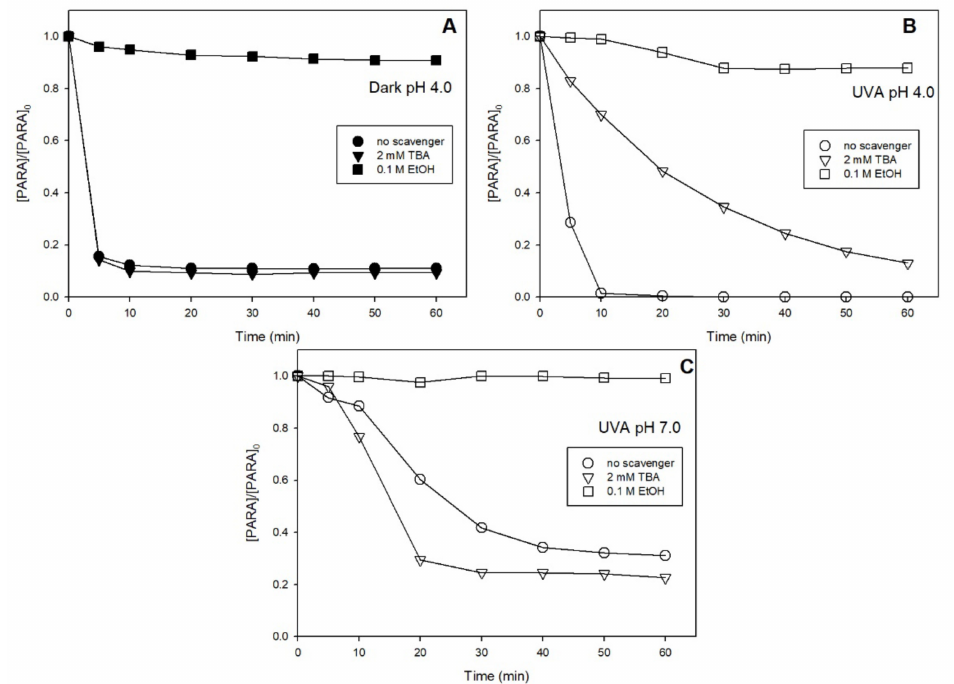
Figure 6. Effect of radical scavengers on PARA degradation in the dark at pH 4.0 ( A ) and under UVA at pH 4.0 ( B ) and 7.0 ( C ). Conditions: [PARA] 0 = 10 µ M, [S(IV)] 0 = 1.0 m M , [Fe(III)] 0 = 0.1